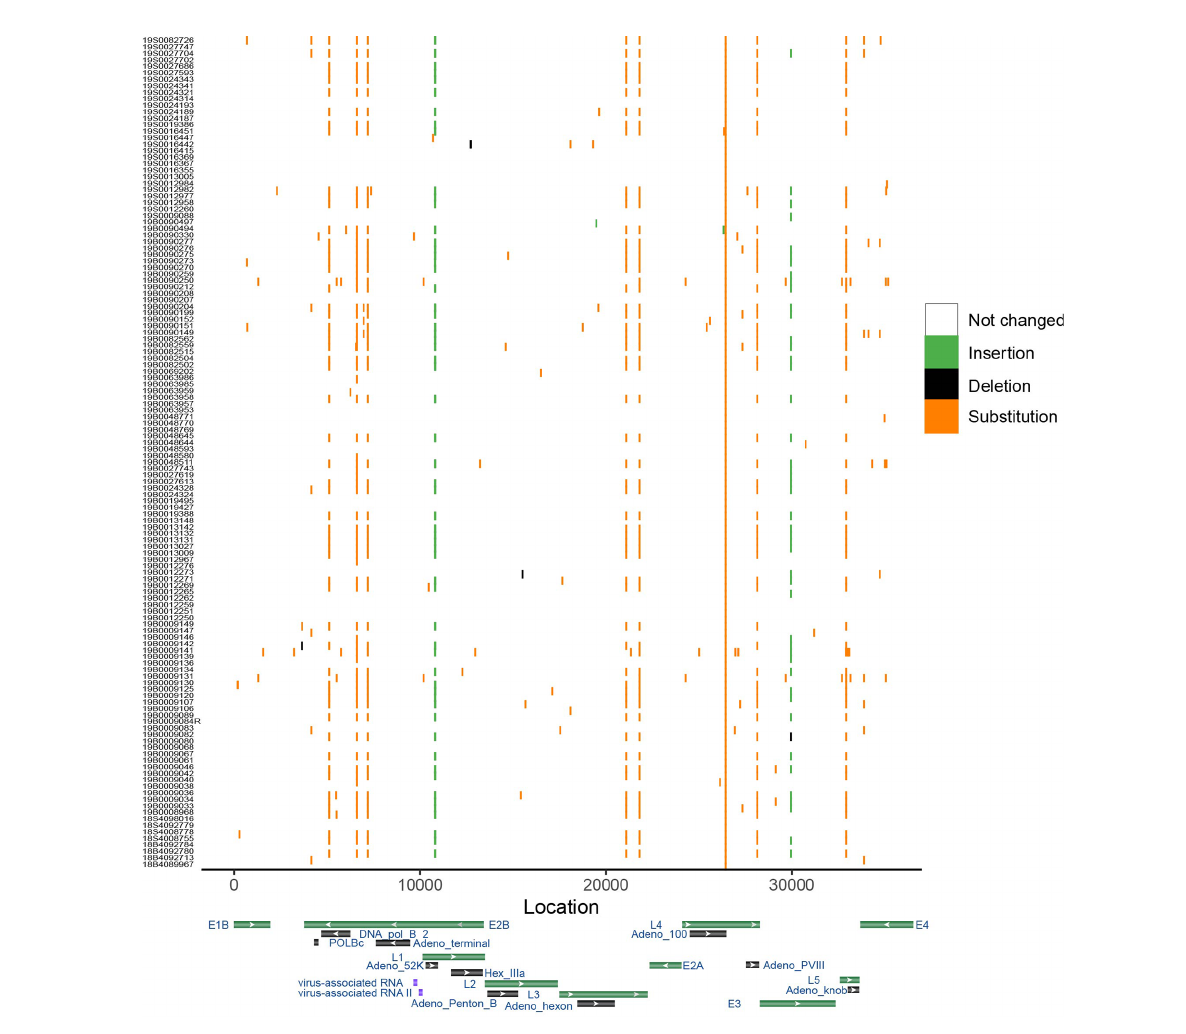
FIGURE 4 | Genome variation of HAdV-7. Genome MN307150 was chosen as the reference. Color shows the type of mutation. X-axis represents the location of genome and y-axis shows the corresponding samples. Gene map displayed several important gene of adenovirus based on the Genbank